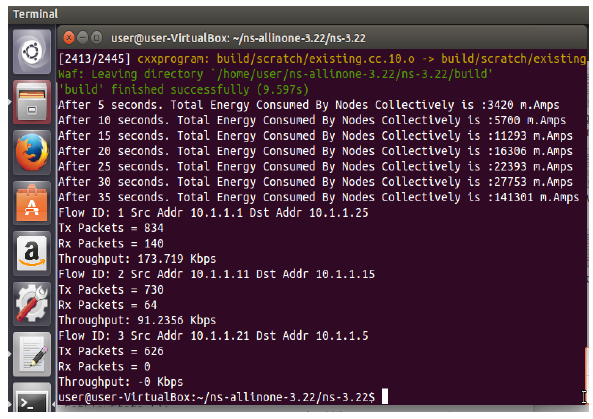
Figure 8. Energy-Utilization w.r.t. QoPML